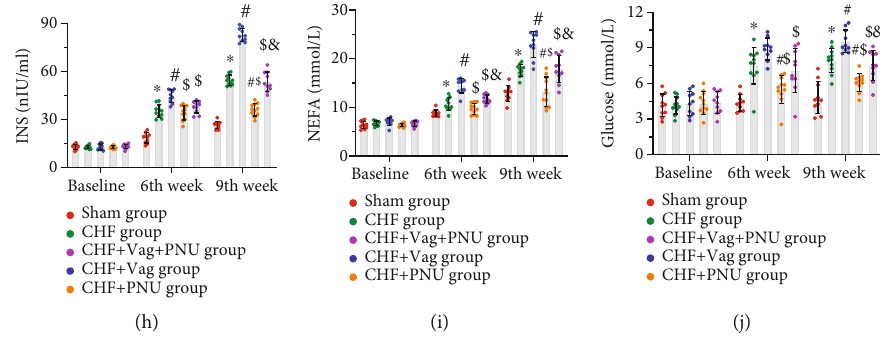
Figure 2: E ff ects of cholinergic elicitation on cardiac dysfunction and cardiac energy metabolism alterations. Representative M-mode echocardiogram of short-axis views from fi ve groups (a). Comparisons of LVEDd (b), LVEF (c), LVFS (d), and ATP (F) among fi ve groups. Correlation between LVEDd values of the 9 th week and ATP contents (g). Di ff erences of BNP (e), INS (h), NEFA (i), and glucose (j) among fi ve groups at baseline, the 6 th week, and the 9 th week. ∗ P < 0 : 05 vs. Sham group. # P < 0 : 05 vs. CHF group. $ P < 0 : 05 vs. CHF+Vag group. & P < 0 : 05 vs. CHF+PNU group. LVEDd: left ventricular end-diastolic dimension; LVEF: left ventricular ejection fraction; LVFS: left ventricular fraction shortening; BNP: brain natriuretic peptide; ATP: adenosine triphosphate; INS: insulin; NEFA: nonesteri fi ed fatty